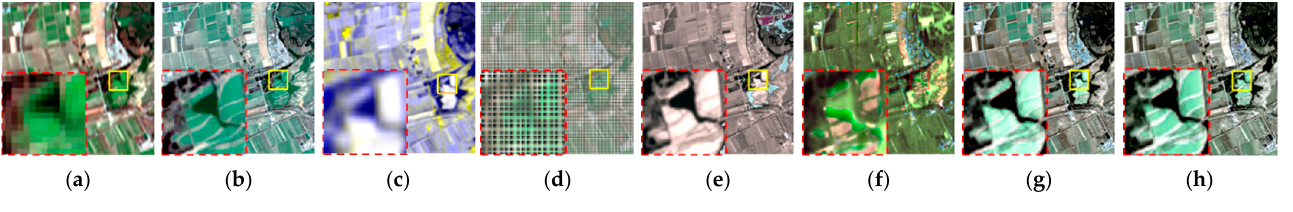
Figure 5. SRR results of ZY-1 02D HSI. ( a ) HSI; ( b ) MSI; ( c ) MIAE; ( d ) FuVar; ( e ) ECCV14; ( f ) ICCV15; ( g ) CNMF; and ( h ) ours.